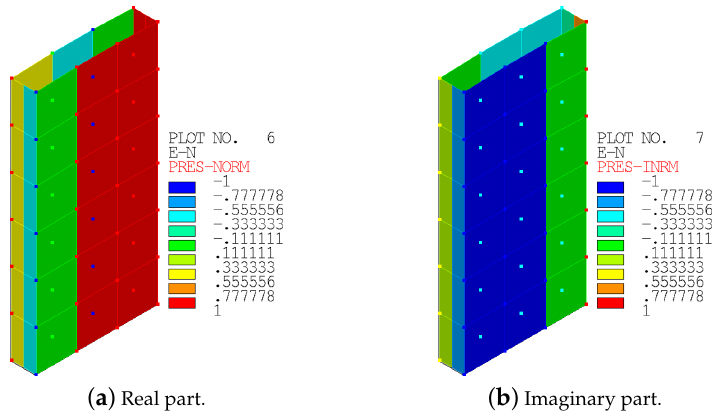
( a ) Real part. ( b ) Imaginary part. Figure 5. Forcing function distribution mapped on the FEM surface (front side, case 3).